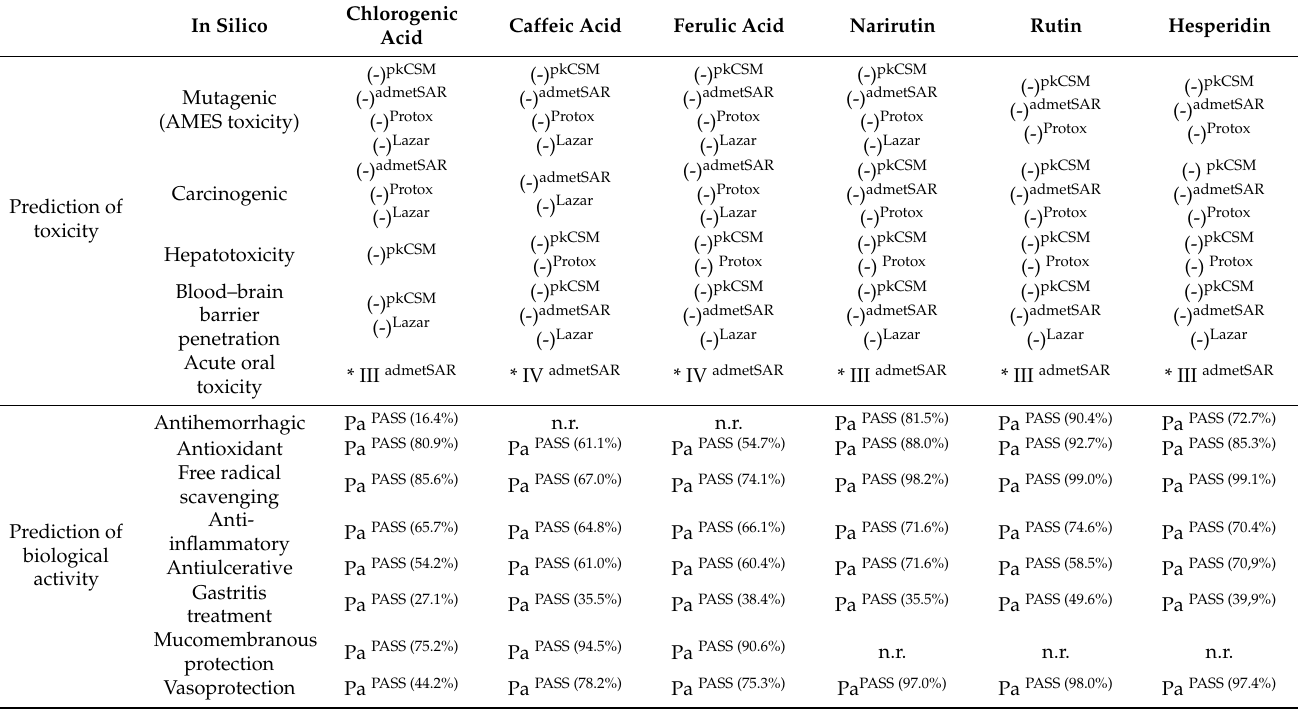
Table 4. In silico prediction of toxicity and biological activity based on the major phenolic compounds present in fermented orange